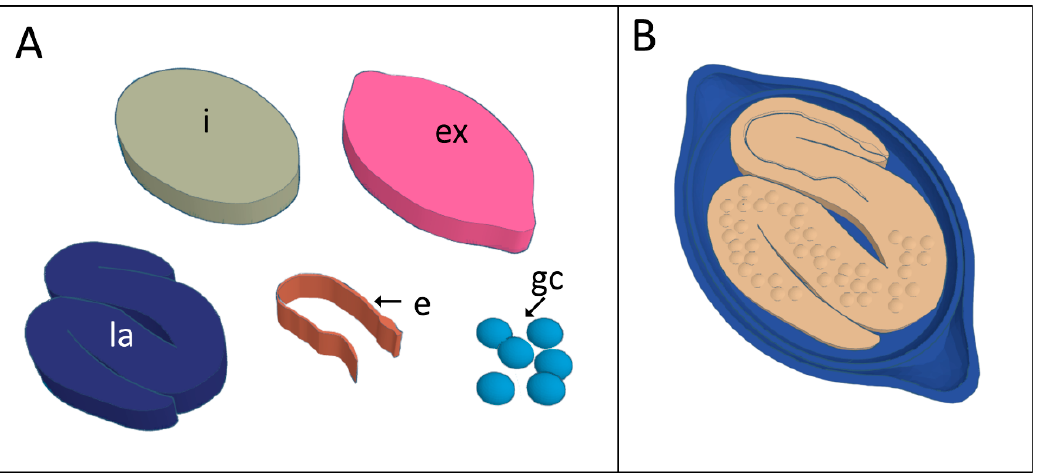
Figure 2. Three-dimensional virtual models of the different parts of the Trichuris muris egg obtained using the Tinkercad website. ( A ): Internal area of the egg (i), external layer (ex), larvae (la), esopha- gus (e), and germinative cells (gc). ( B ): Virtual model of a complete T. muris egg integrating all the different parts shown in Figure 2A.